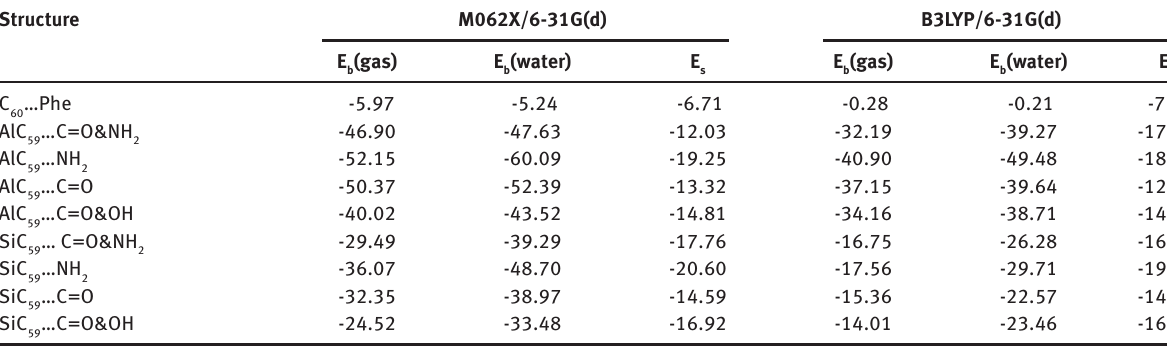
Figure 2: Possible interaction edges and optimized structures for the doped systems with B3LYP/6-31G(d). Table 1: Binding and solvent energies (kcal/mol) of the investigated